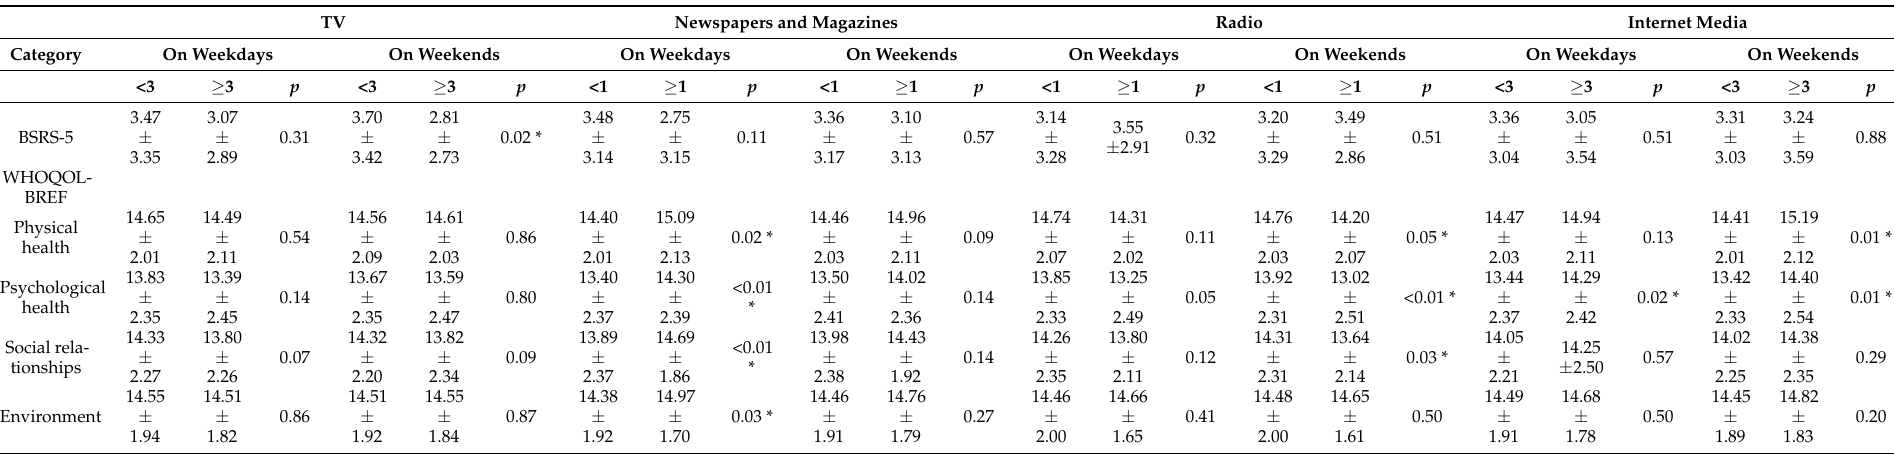
Table 3. Differences between different levels of media users by hours in the BSRS-5 and